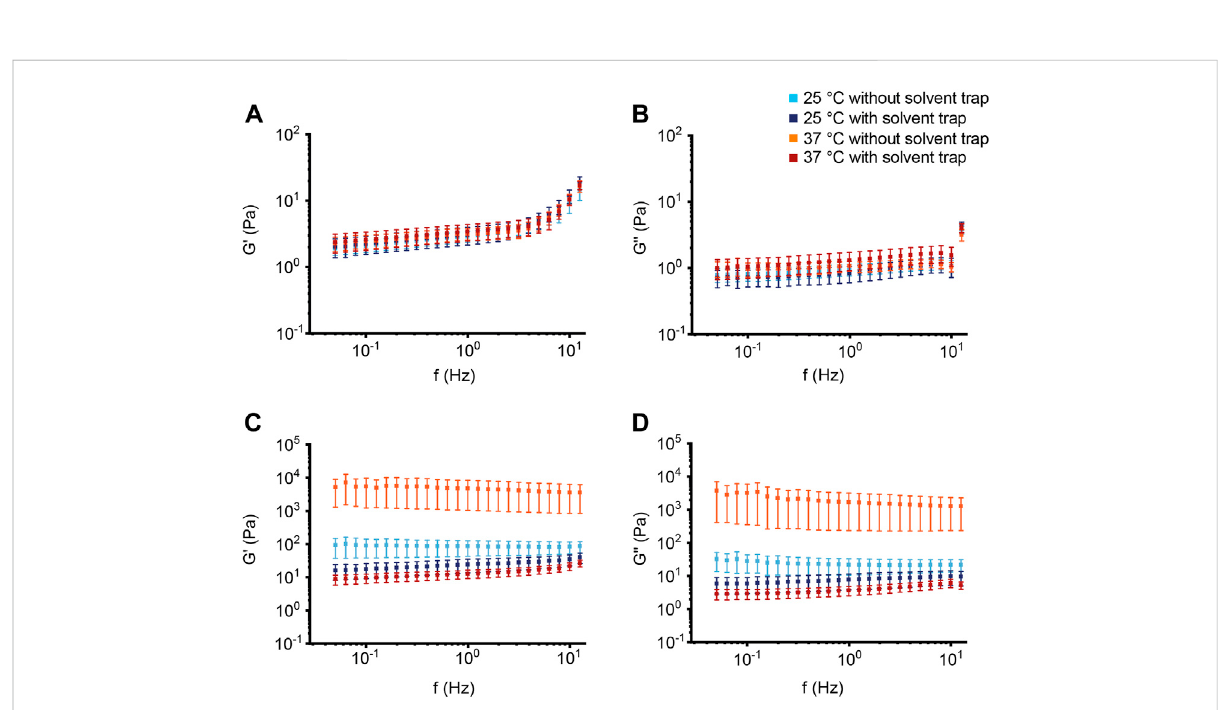
FIGURE 4 Effect of temperature and saturated atmosphere on macrorheology of healthy and cystic fi brosis sputum. (A,C) Storage modulus G ′ and (B,D) lossmodulusG ″ ofsputumfrom (A,B) healthycontrols( n =10)andfrom (C,D) patientswithCF( n =10)weremeasuredasfunctionoffrequency(Hz). Data are shown as mean ± standard error of the mean (SEM) of measurements at 25 ° C and 37 ° C with and without solvent